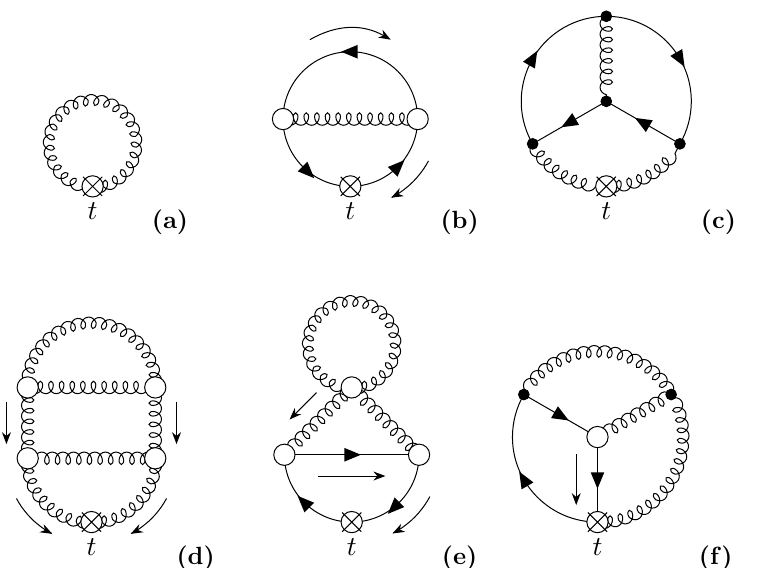
S ( t ) h i S ( t ) h i